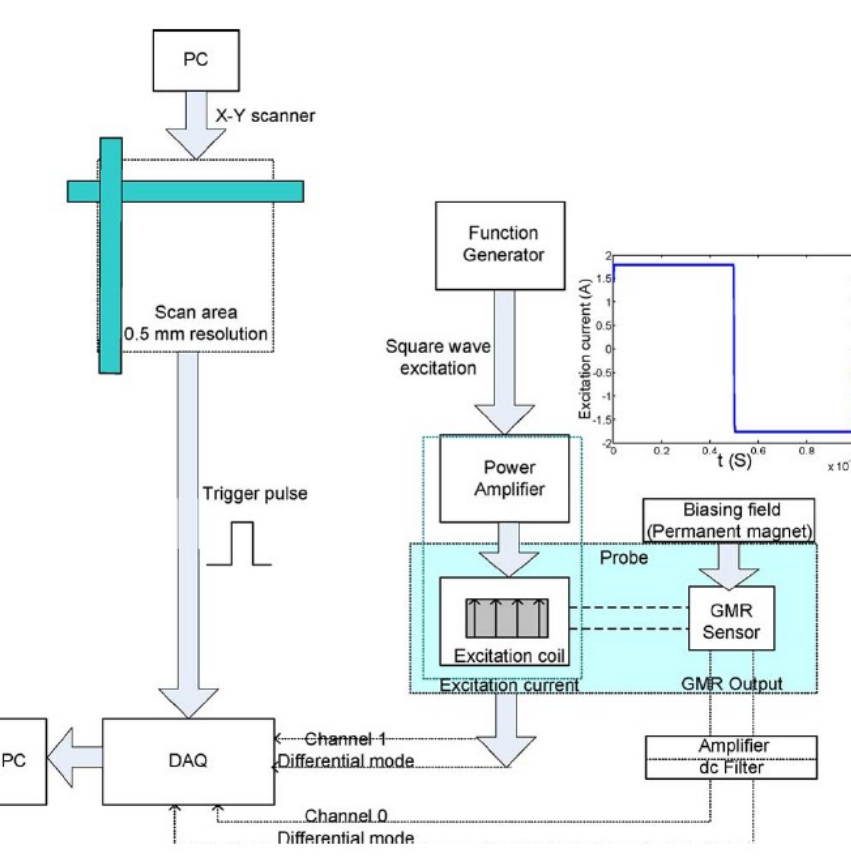
Figure 19. Schematic of the PEC-GMR imaging